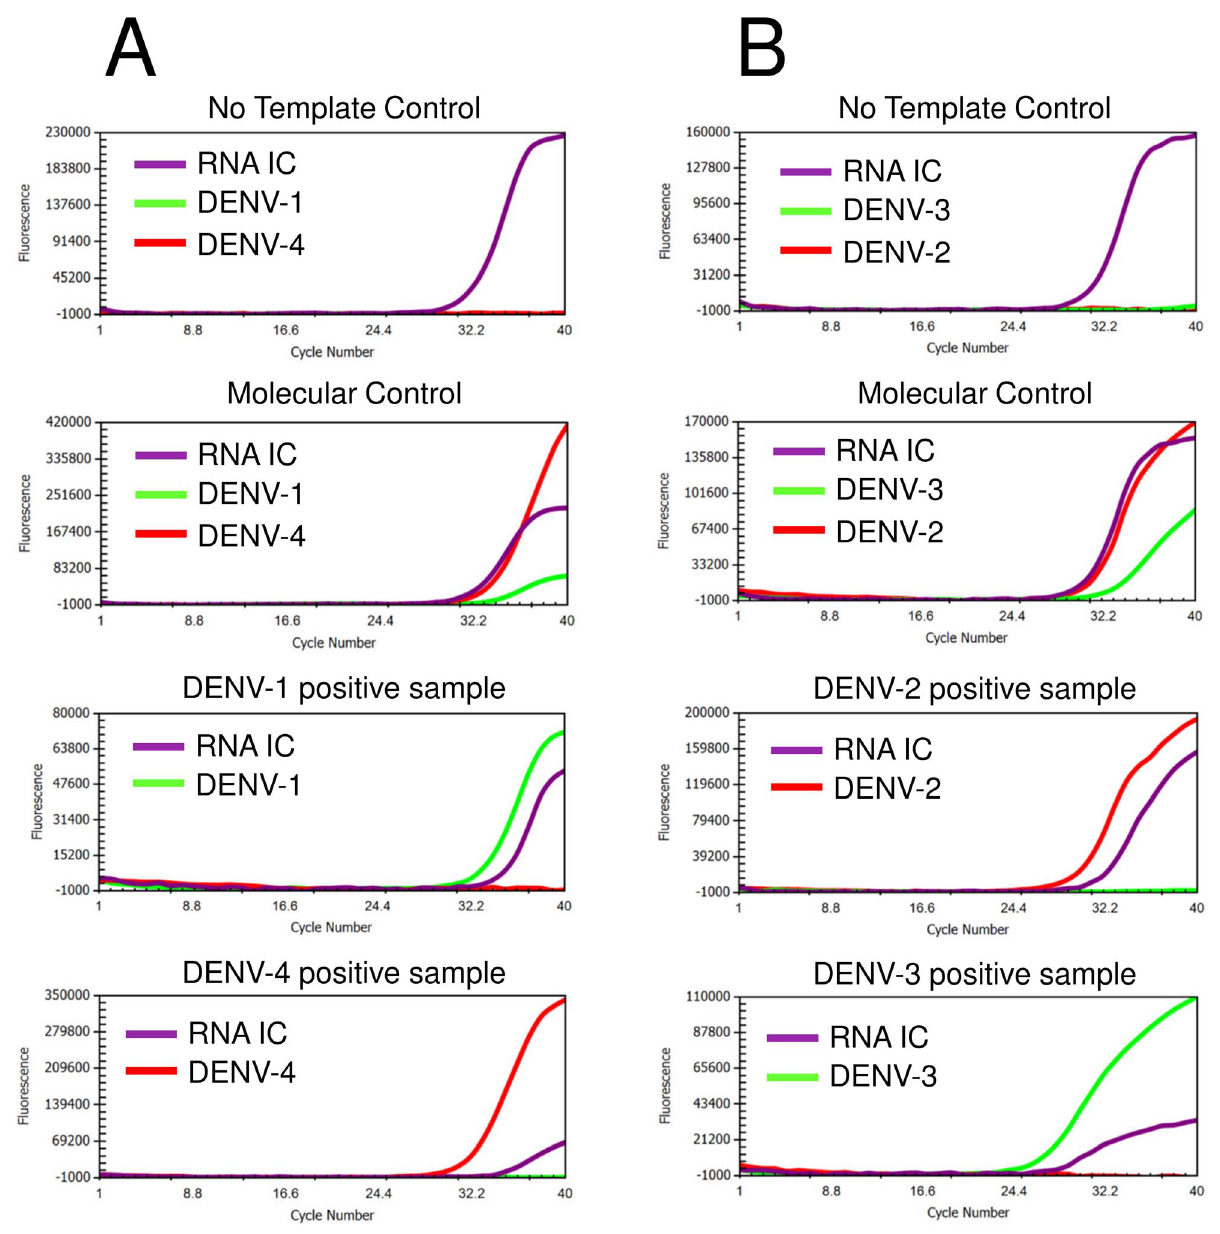
Figure 1. Representative of Simplexa Dengue real-time RT-PCR amplification curves of dengue detection. Detection reactions were separated in two tubes, i.e. DENV-1 and DENV-4 (A) and DENV-2 and DENV-3 (B). Assessment of results were based on the value of controls, which include the Molecular control (MC), RNA internal control (RNA IC) for extraction, and no-template control (NTC).